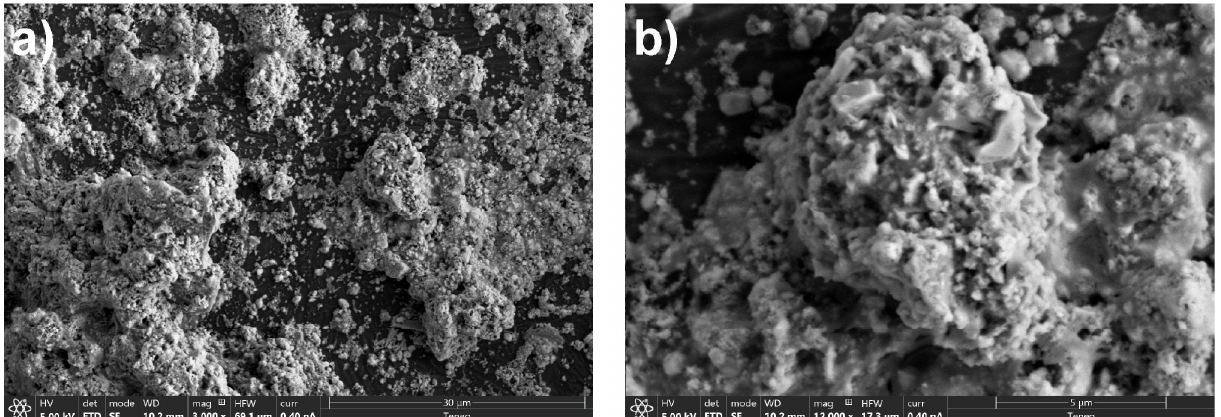
Figure 4. Scanning electron microscope images of biomass bottom ash at different magnifications in the secondary option. ( a ) 3000X. ( b ) 12000X.